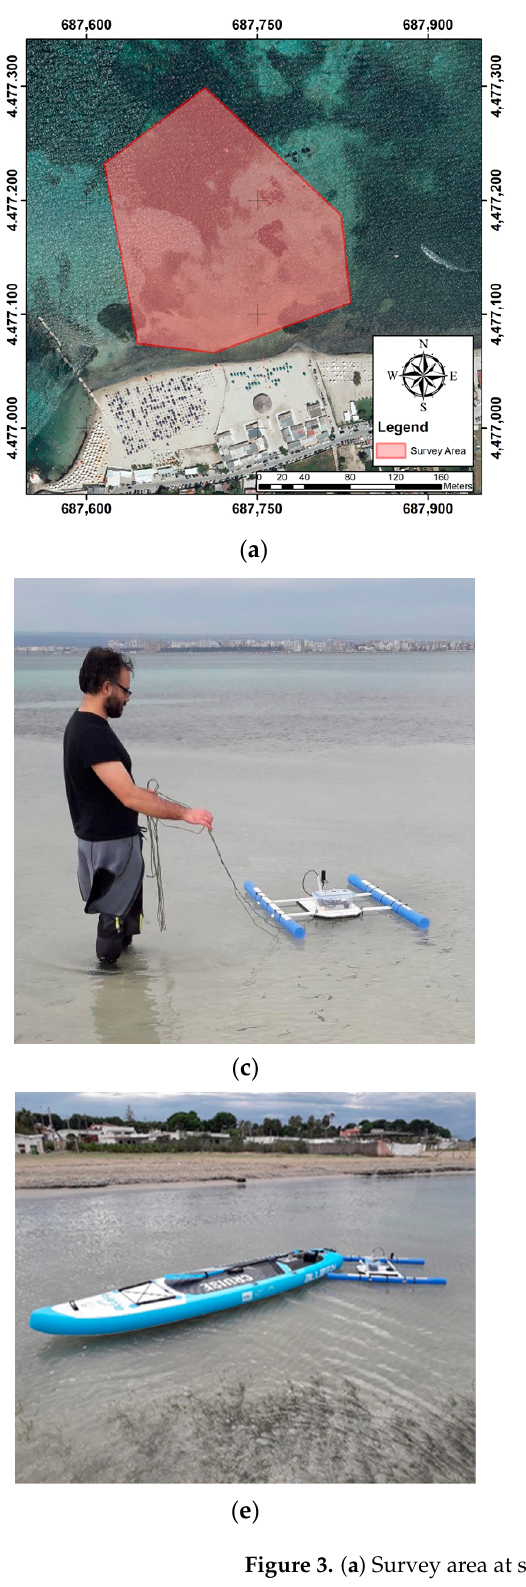
Figure 4. Implementation of the pipeline for 3D modelling of bathymetric data derived from the G > S > P Sys.